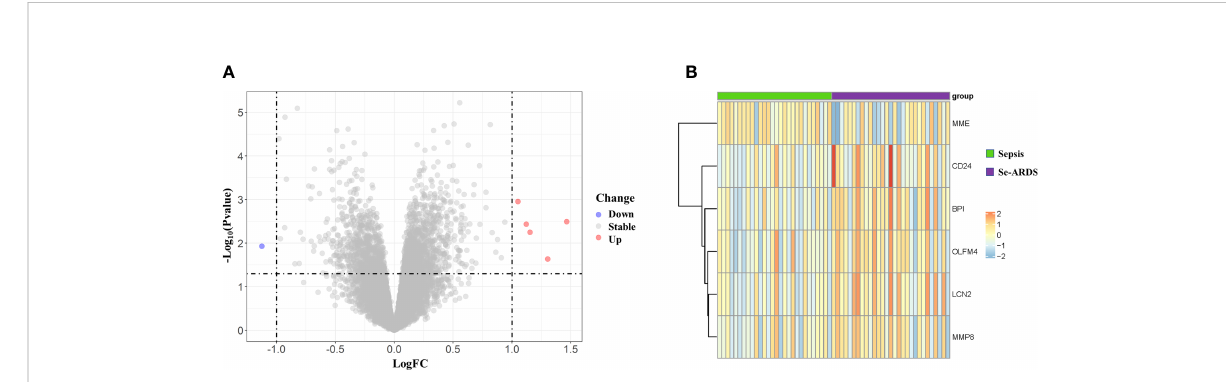
FIGURE 1 Identi fi cation of differently expressed genes (DEGs) associated with the onset of ARDS in septic patients. Six DEGs were identi fi ed between critically ill patients with sepsis alone and septic patients who developed ARDS, as visualized by volcano plot (A) as well as heatmap (B) .